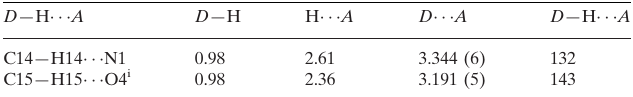
Hydrogen-bond geometry (A˚ , (cid:3)